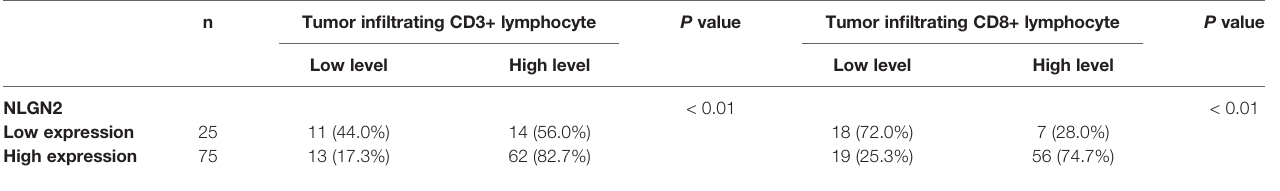
TABLE 2 | The relationship between NLGN2 expression and CD3+ and CD8+ tumor in fi ltrating lymphocytes.